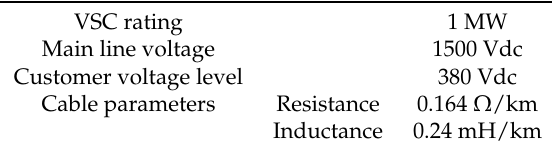
Figure 6. Modified IEEE 13 node test System. Table 2. Simulation